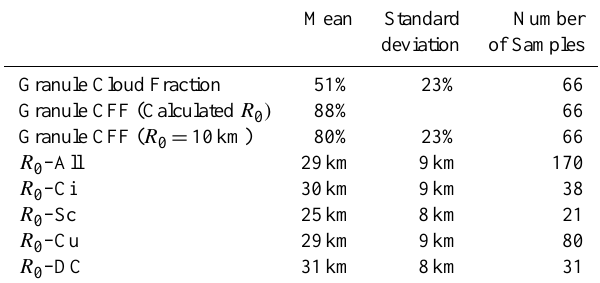
Table 1. Granule cloud fraction (CF), cloud field fraction (CFF), and field distance parameters ( R 0 ) as calculated globally for 28 July 2008. The cloud fields are classified to: Ci, Sc, Cu, and Deep Convective (DC). It refers both to fields and granules, respec- tively. Mean Standard Number deviation